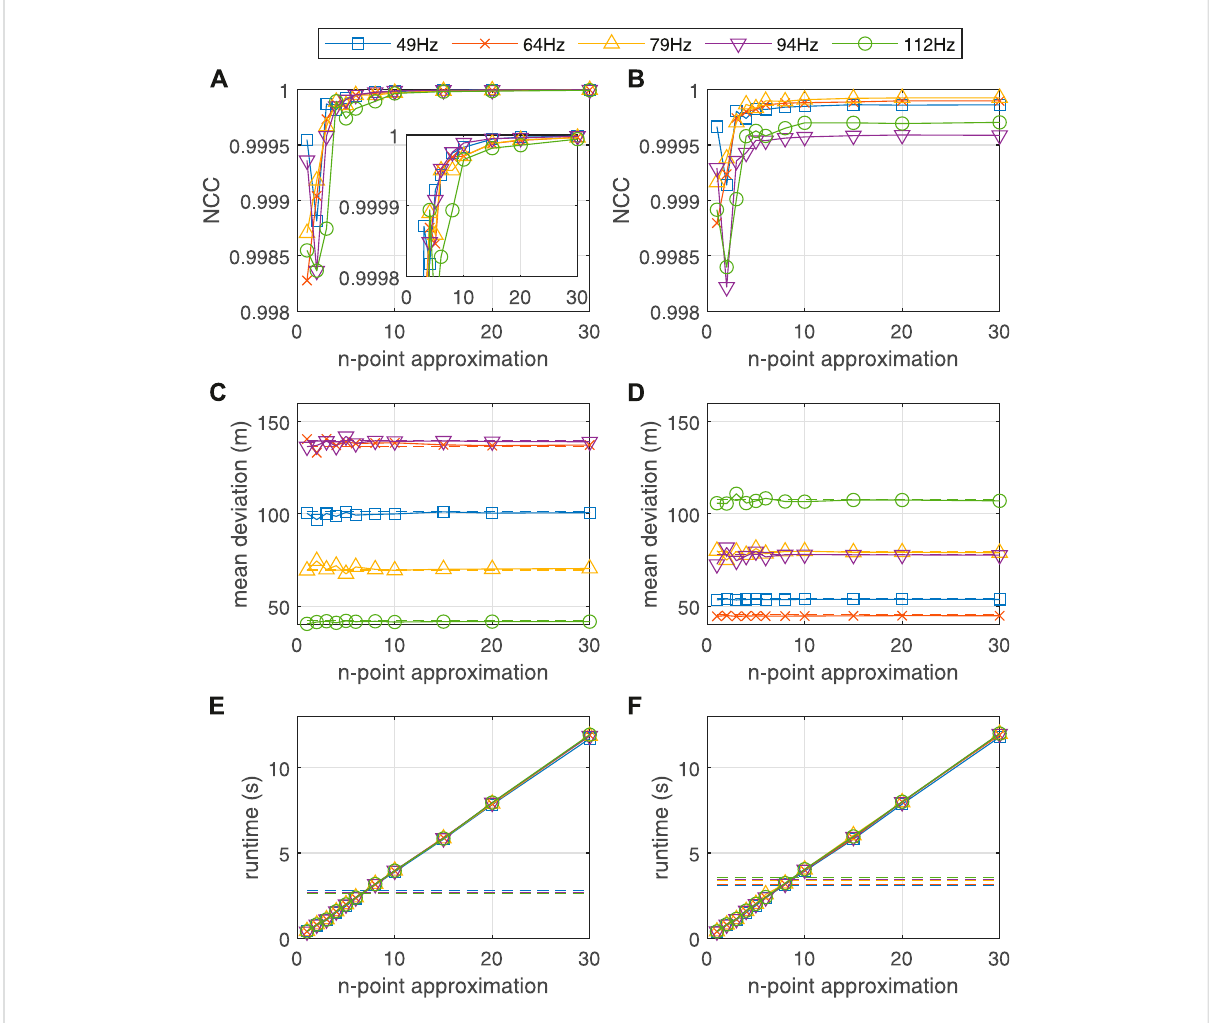
FIGURE 7 Changes of the NCC coef fi cient (A,B) , the mean deviation between source range estimates and GPS records (C,D) , and the runtime of computing a TFD (E,F) with the increase of the number of compensation points. Results of F-STFT are shown in the left three panels (A,C,E) , while that of F-DopplerCT are shown in the right three panels (B,D,F) . Dash lines in (C – F) represents the corresponding results of STFT and